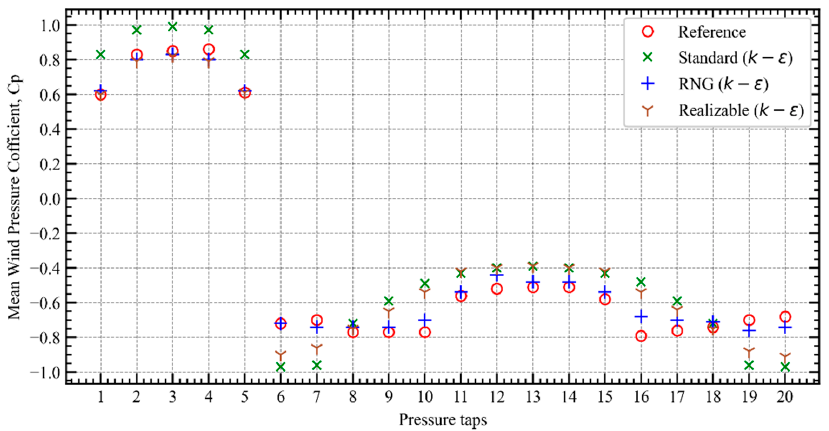
Figure 3. C p values for different turbulence models. Figure 3. Cp values for different turbulence models. Figure 3. Cp values for different turbulence models.